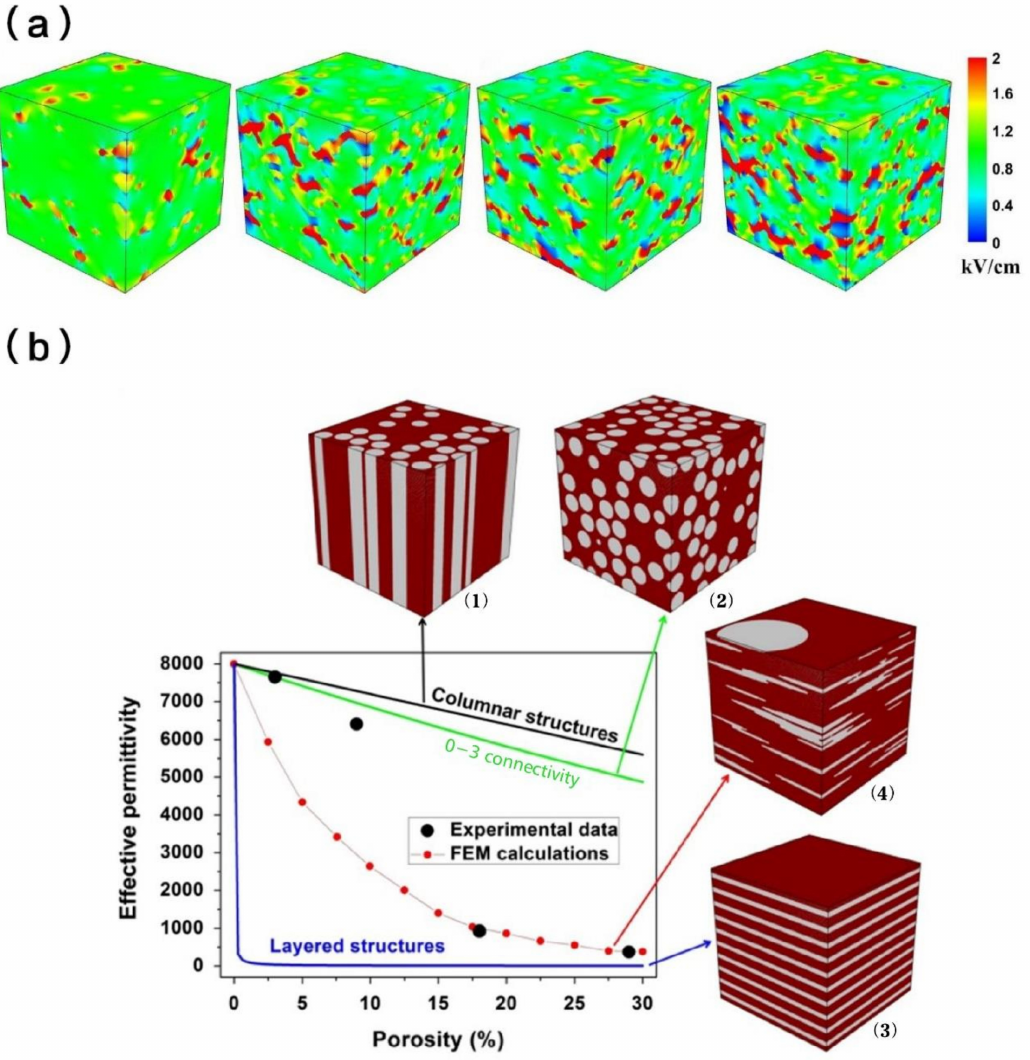
Figure 5. Simulation of porous materials: ( a ) Effect of porosity on electric field distribution [110], Reproduced with permission, Copyright 2016, J. Am. Ceram.; ( b ) Influence of pore morphology on the electric field [66]. Reproduced with permission, Copyright 2015, J. Alloy.